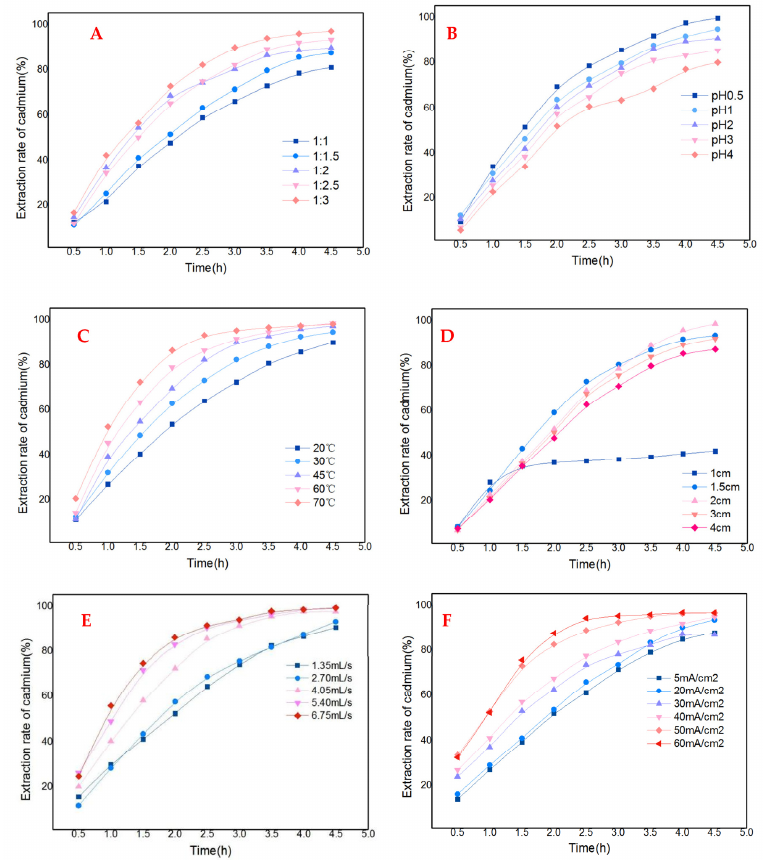
Figure 5. Single factor experimental analysis of process conditions, where ( A ) is electrode area ratio, ( B ) is pH, ( C ) is reaction temperature ( D ), is plate spacing, ( E ) is electrolyte circulation rate, and ( F ) is current density.